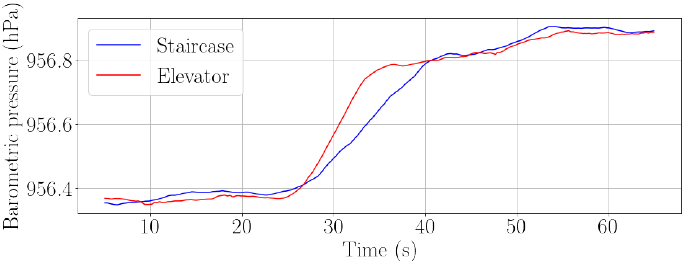
Figure 14. Comparison of the recorded barometric pressure when a passenger is using a staircase (blue) and an elevator (red) at walking speed (around 3.5km/h).